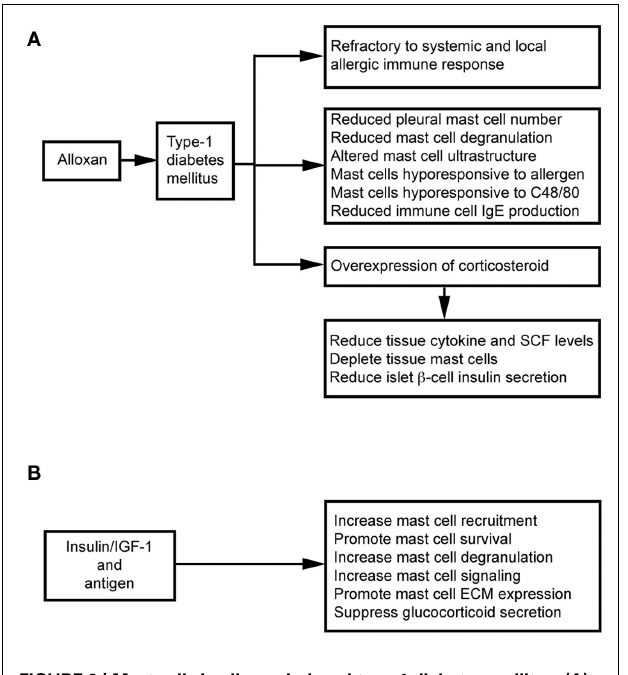
FIGURE 3 | Mast cells in alloxan-induced type 1 diabetes mellitus. (A) Alloxan induces type 1 diabetes and suppresses mast cell activities. (B) Insulin therapy improves mast cell activities in alloxan-induced type 1 diabetes